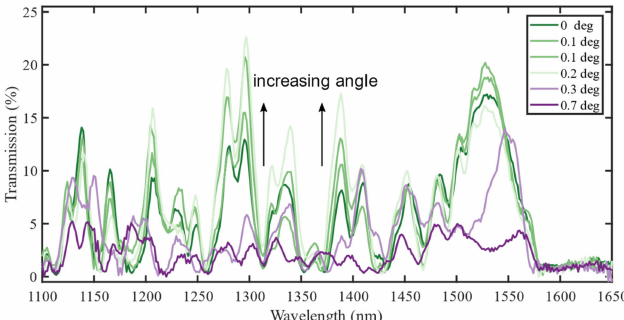
Figure 2. Experimentally measured spectra of a 14.2 mm coreless (CL) interferometer. The spectra (0.2 and 0.3 degrees) are shifted 6 nm to align better for comparison. This corresponds to a cleave length accuracy of ± 70 µ m according to the results in this